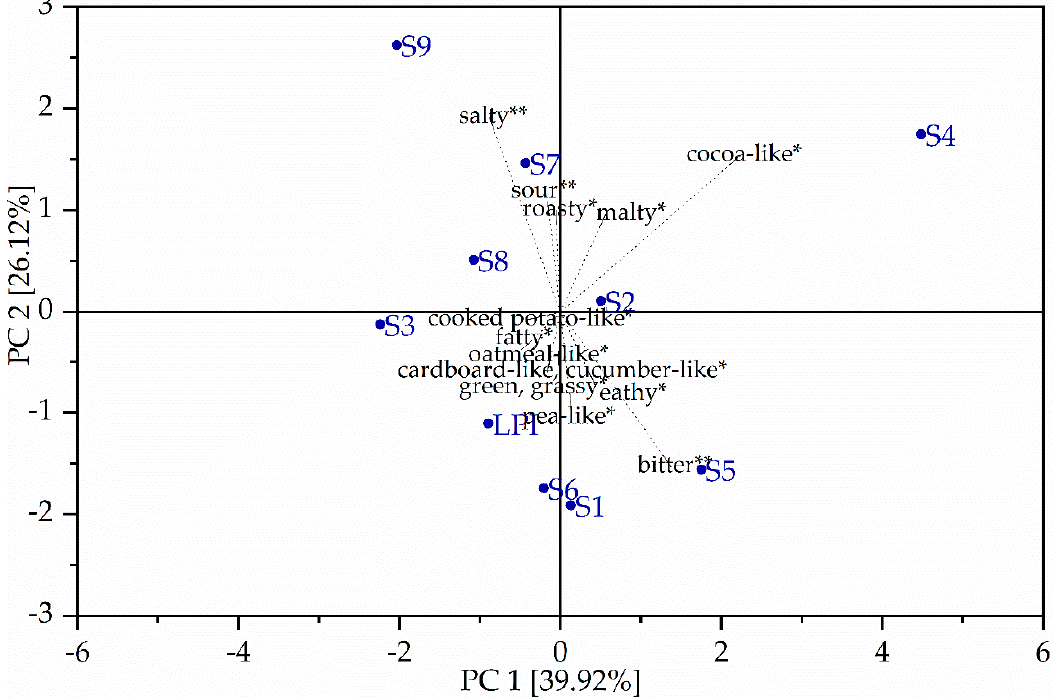
Figure 5. Biplot of aroma and taste of the unfermented LPI and fermented LPI hydrolysates. * aroma ** taste.